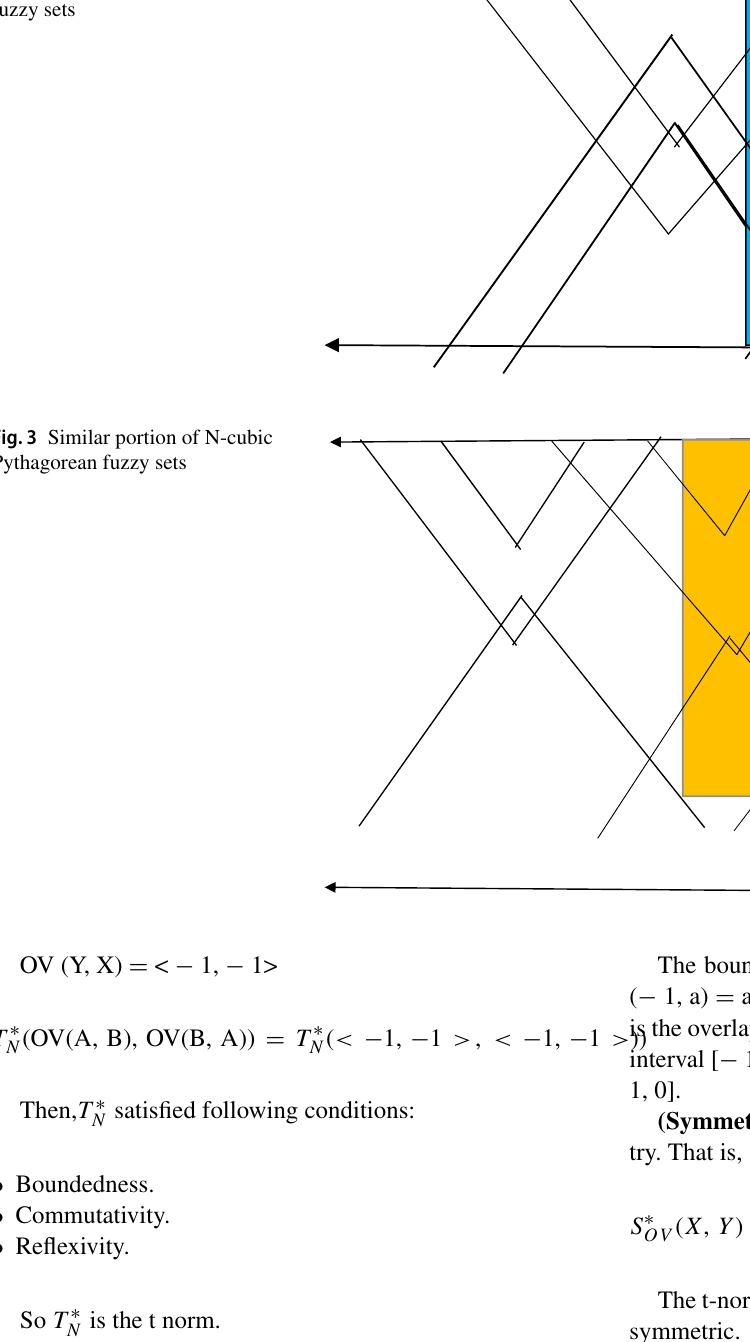
Fig. 2 Similar portion of two interval-valued Pythagorean fuzzy sets